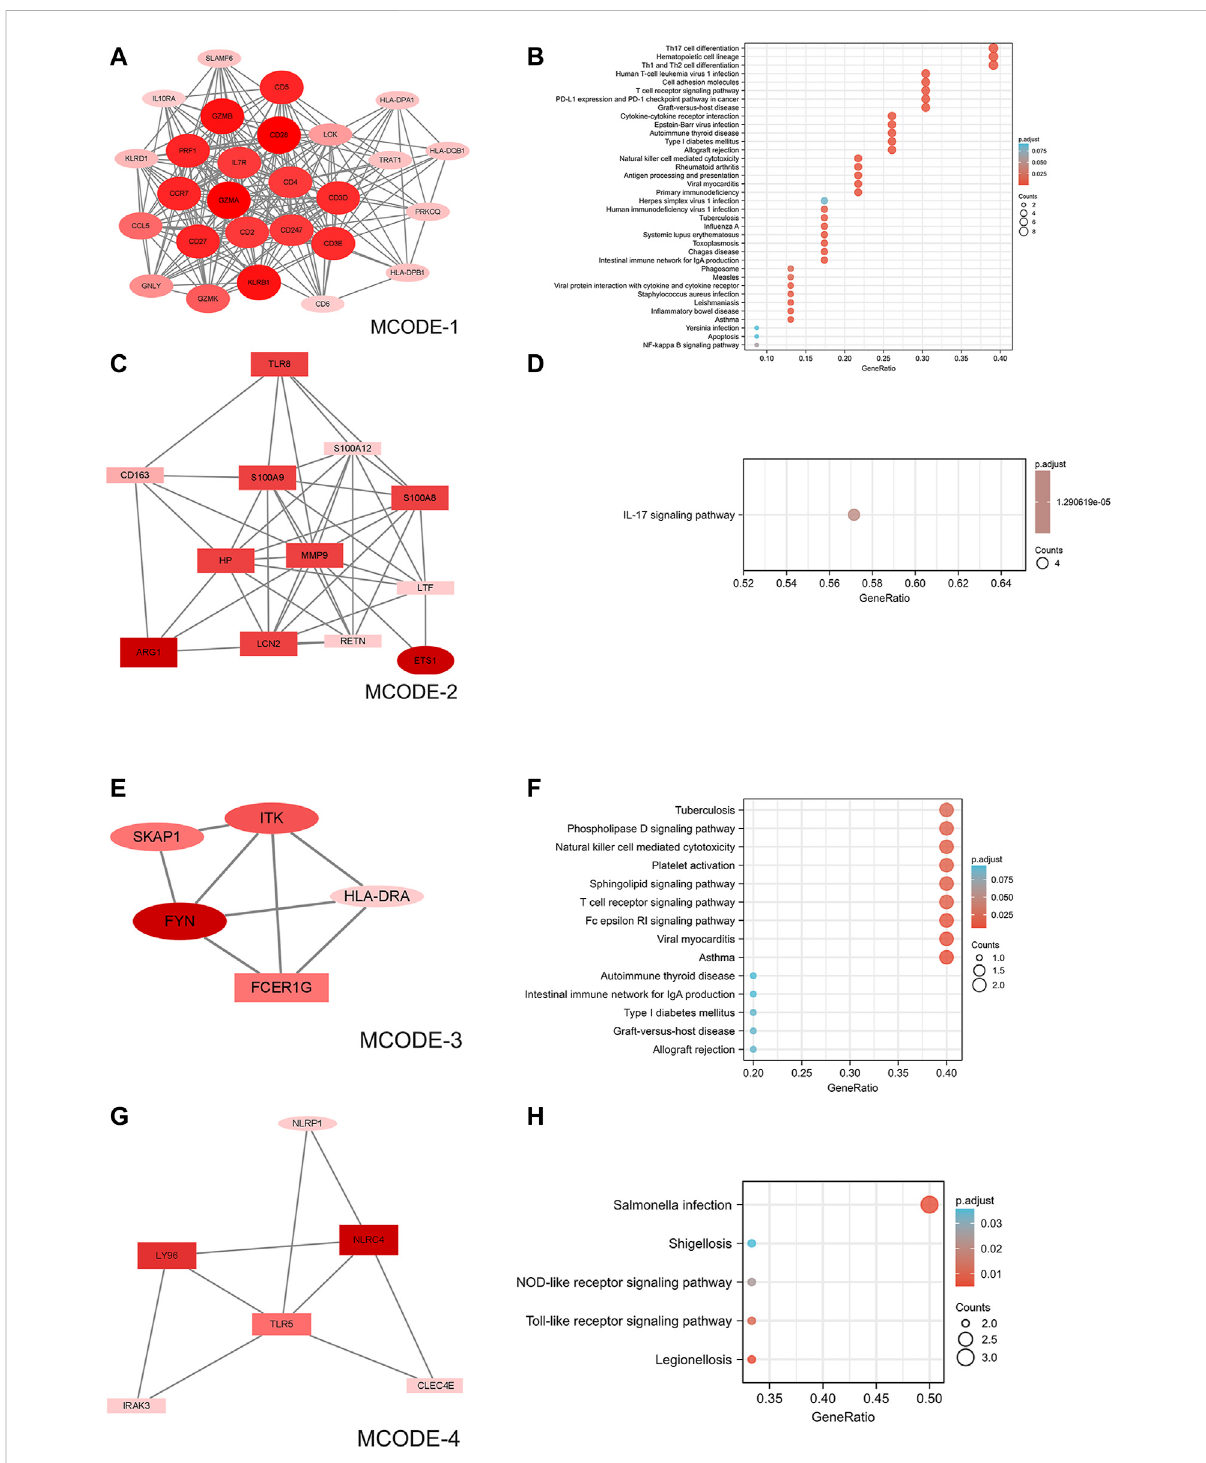
FIGURE 3 PPI network of DEmRNAs and four cluster modules extracted by MCODE. The interaction network between proteins coded by DEmRNAs was comprised of 317 nodes and 1,163 edges (Supplementary Image 8). (A, C, E, G) Use Cytoscape plugin MCODE to fi lter the important modules in DEmRNAs, and then fi lter the fi nal 4 important modules according to the fi ltering criteria. The nodes represent proteins of DEmRNAs, while each edge representsoneprotein – proteinassociation.Largeranddarkernodes(proteins)indicatemoreinteractions(higherdegree).Reddiamondsrepresent the upregulated genes, and green hexagons represent the downregulated genes. Ellipses represent downregulated mRNAs and rectangles represent upregulated mRNAs. (B, D, F, H) Results of the 4 important modules pathway enrichment analyses. DEmRNAs, differentially expressed